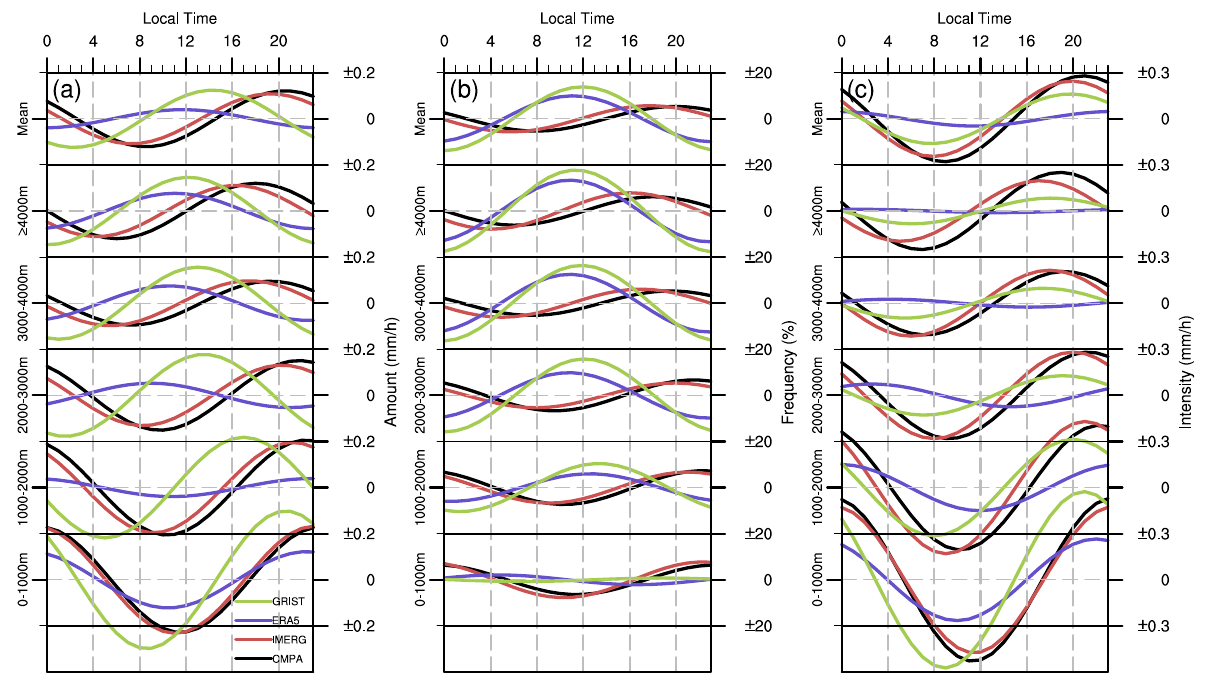
Figure 9. Elevation dependence of the diurnal harmonic of precipitation variables (( a ) amount (mm/h); ( b ) frequency (%); ( c ) intensity (mm/h)) in EPTP. Horizontal solid black lines separate different altitude blocks, and the horizontal dashed gray line in the center of each block marks the zero line. The altitude of each block increases from bottom to top, with the mean diurnal harmonic of EPTP displayed in the block at the top. The labels on the right Y -axis represent the values of the diurnal harmonic curve, with positive (negative) values above (below) the zero line (negative). The labels on the left Y -axis indicate the altitude intervals represented by each subgraph. The X -axis indicates the hour (local time) of the 24-h rainfall cycle. Black stands in for the CMPA dataset, red for IMERG, violet for ERA5, and green for